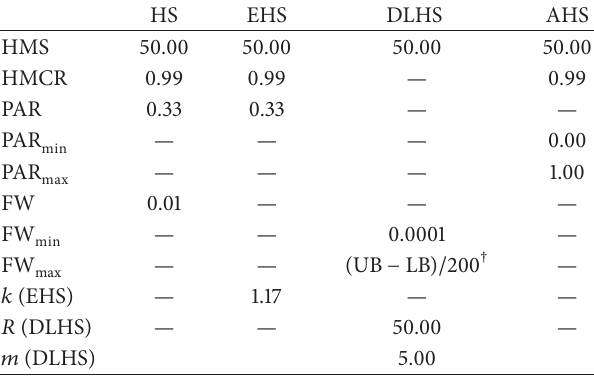
Table 1: Parameter sets as suggested by the original authors.